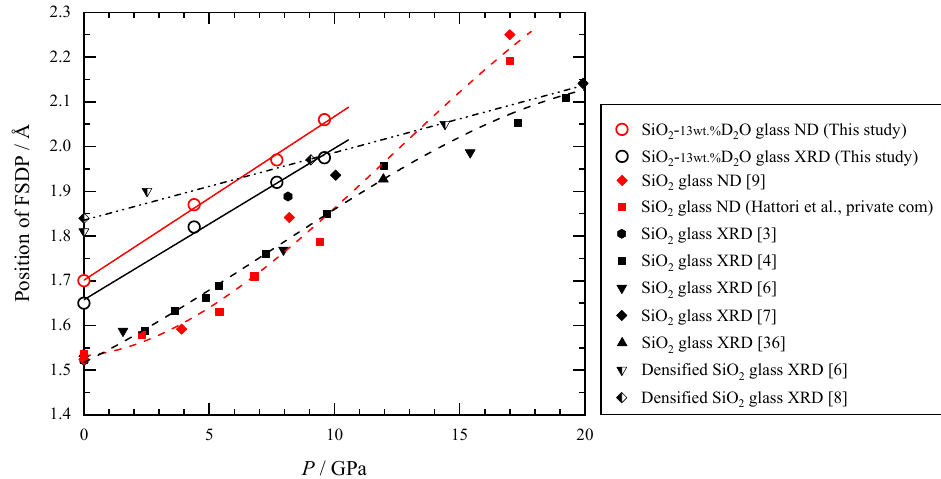
Figure 6. Comparison of the position of the first sharp diffraction peak (FSDP) of S X ( Q ) and S N ( Q ) between the hydrous and anhydrous SiO 2 glass [3,4,6–8,36].